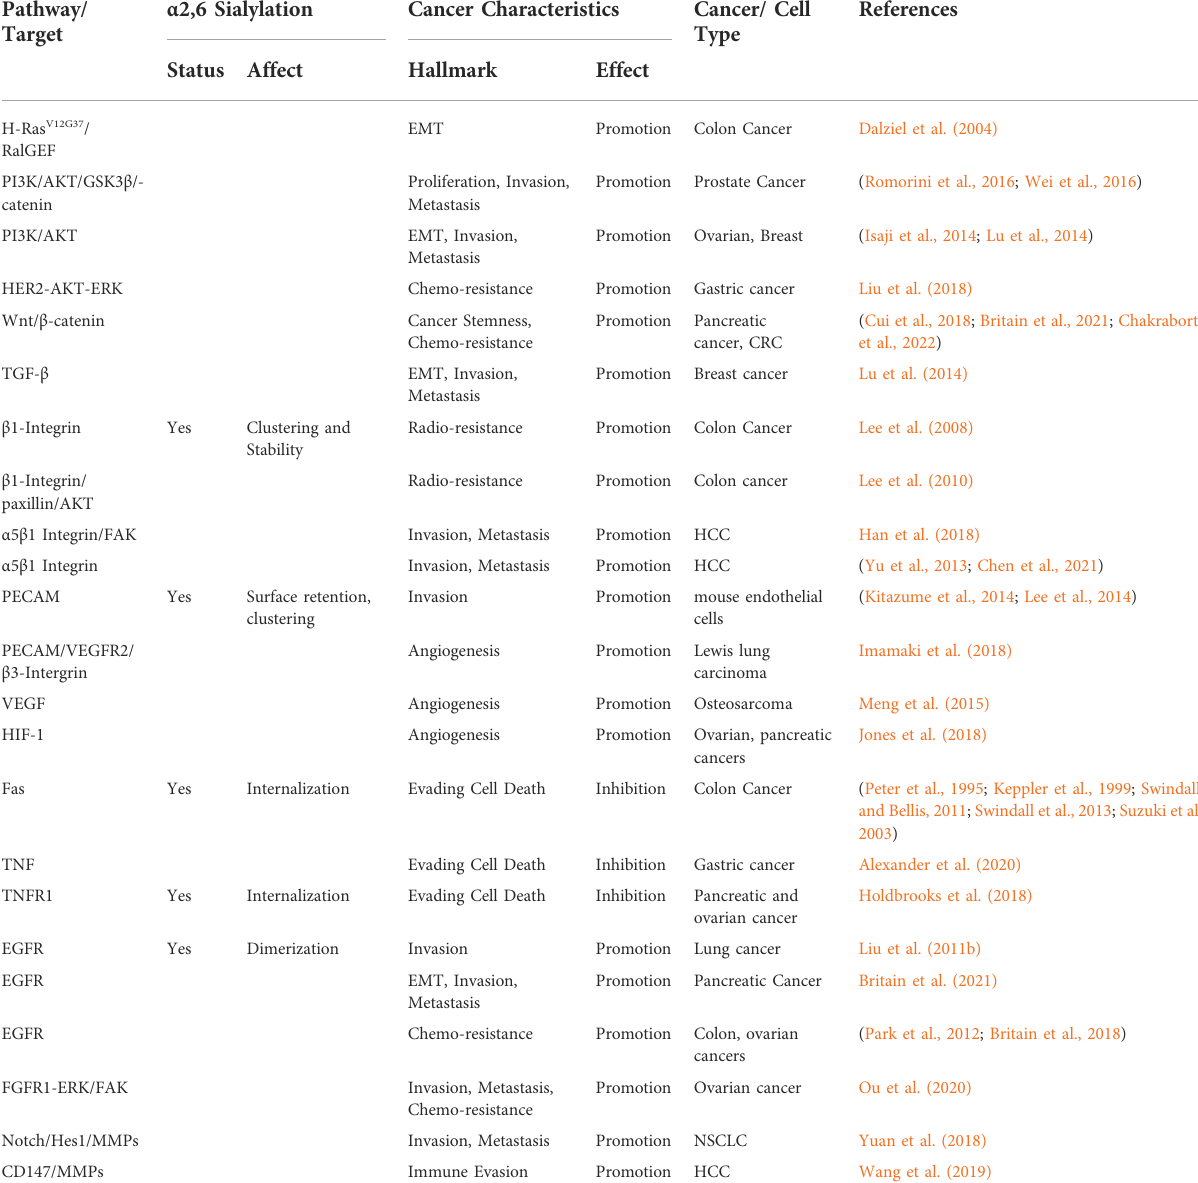
TABLE 1 Pathways and targets affected by ST6Gal1 to impact cancer